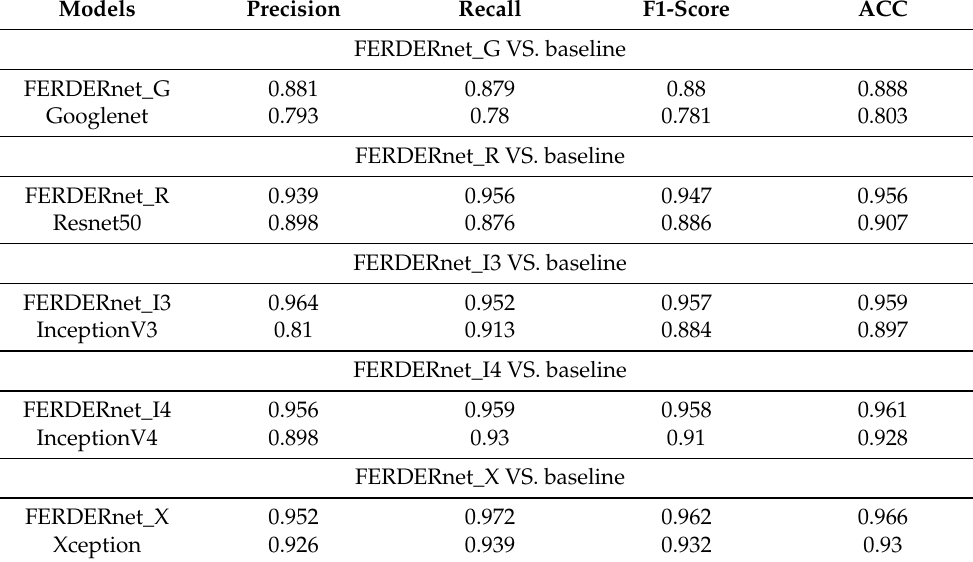
Table 2. Model performance of on-road driver facial expression dataset.